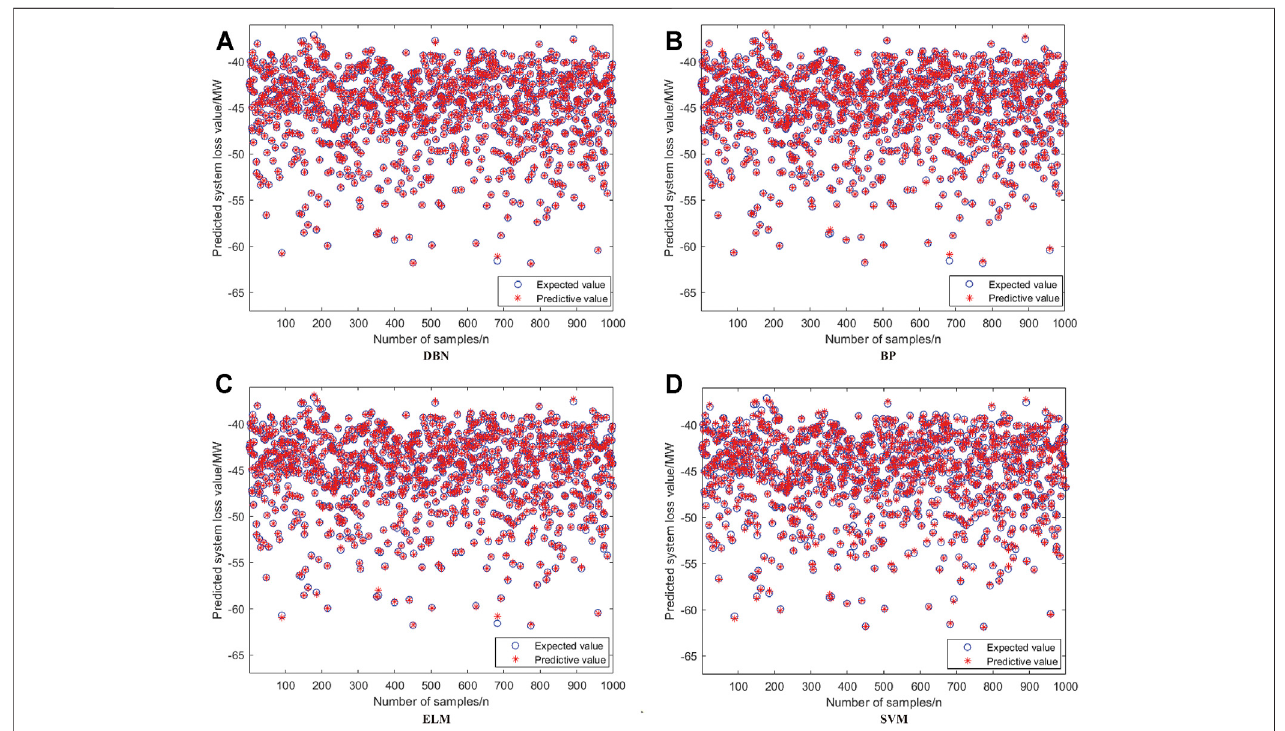
FIGURE 7 | Predicted results of different models on the test set. (A) is DBN, (B) is BP, (C) is ELM, (D) is SVM.